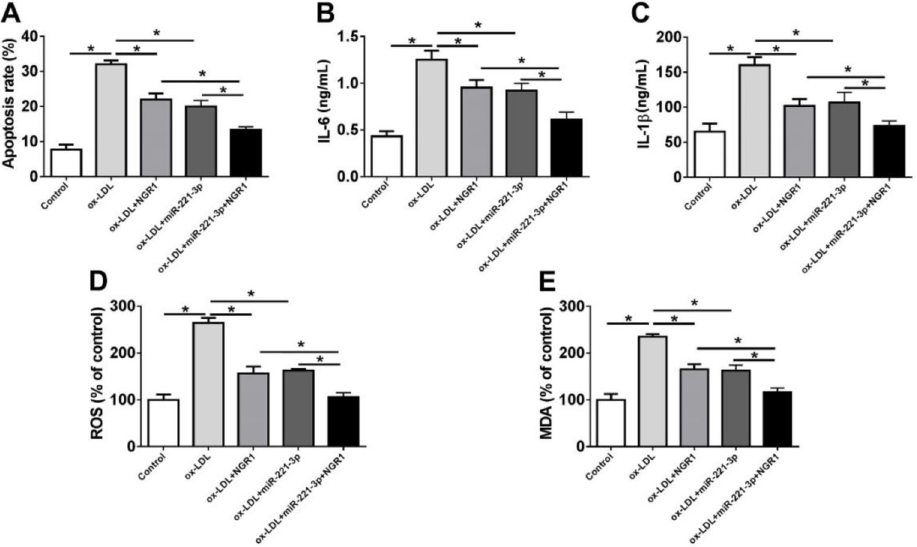
Figure 2. NGR1 participated in the cellular response by promoting the expression of miR-221-3p in induced human umbilical vein endothelial cells (HUVECs). HUVECs were pretreated with miR-221-3p mimic or NGR1, followed by stimulation with 50 mg/L oxidized low-density lipoprotein (ox-LDL). A , Flow cytometry was performed to evaluate cell apoptosis in HUVECs. B and C , The levels of in fl ammatory cytokines interleukin (IL)-6 and IL-1 b were determined by ELISA. D and E , Reactive oxygen species (ROS) and malondialdehyde (MDA) levels were determined by assay kits. Data are reported as means ± SD from three independent experiments. *P o 0.05 (ANOVA).